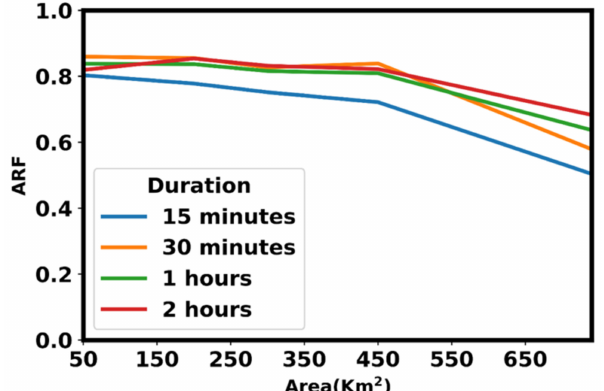
Figure 9. Areal reduction factor for Bangalore for different storm durations as a function of the area. The method suggested in US Weather Service Report TP-29 was used for ARF